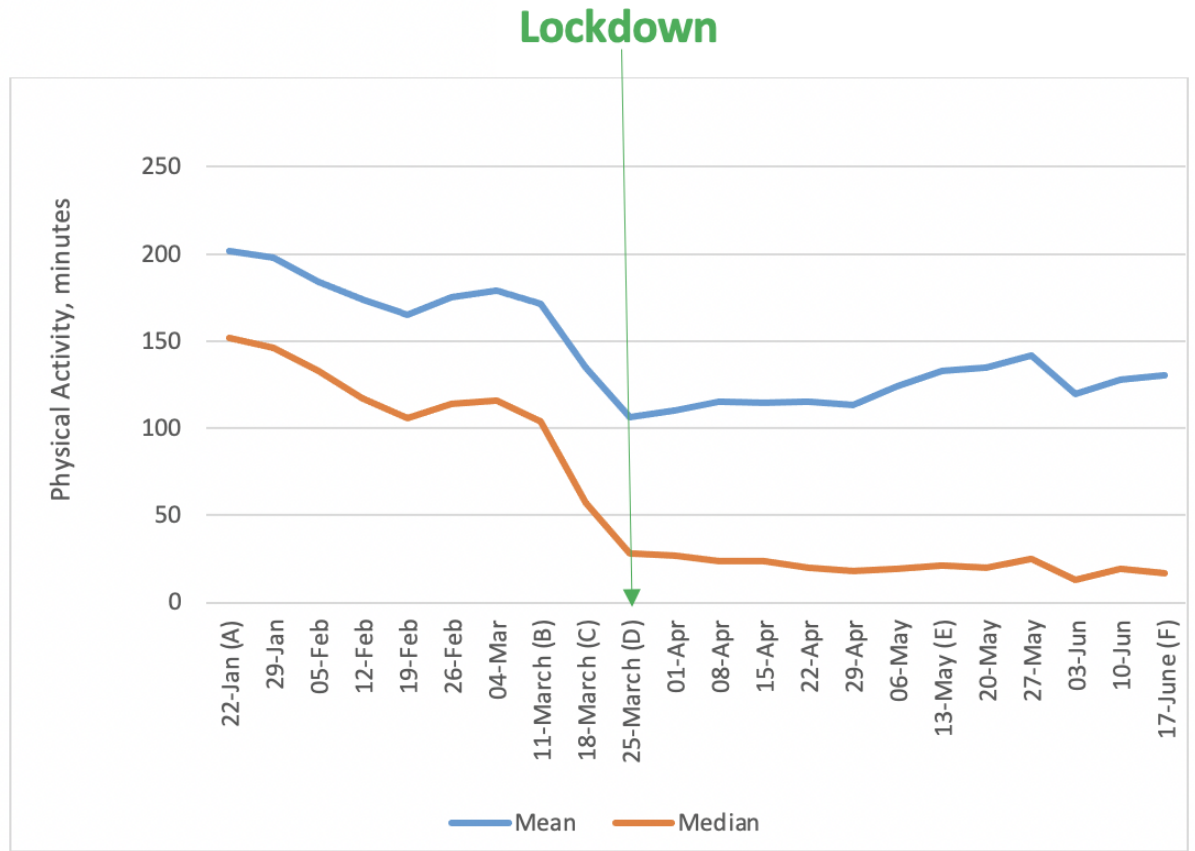
Figure 1. Weekly minutes of physical activity (mean and median). Important dates are marked on the x-axis as follows. (A) January 22: Baseline, week before first COVID-19 case announced in the United Kingdom. (B) March 11: Social distancing measures introduced. (C) March 18: Lockdown begins. (D) March 25: First full week of lockdown. (E) May 13: Lockdown measures relaxed. (F) June 17: Shops